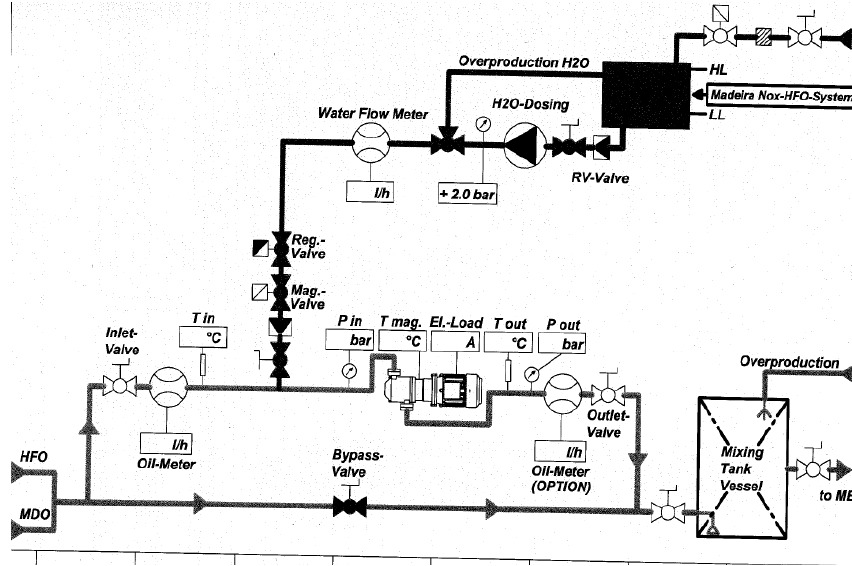
Figure 9. Diagram of S system [53].